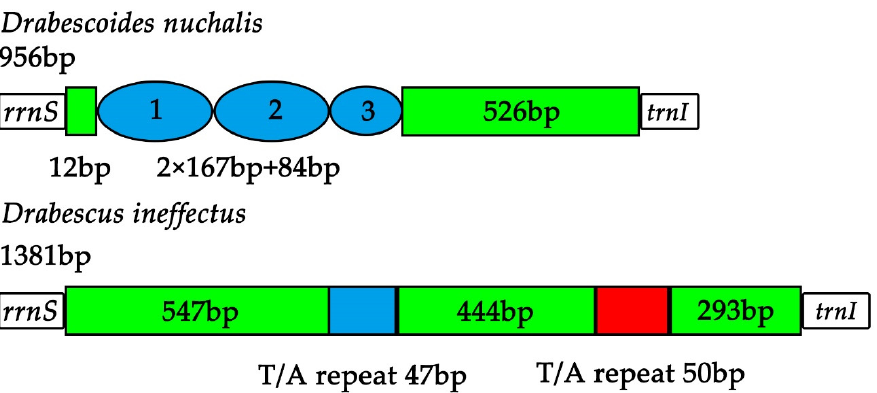
Figure 5. Structures of the A + T ‐ control region in Drabescini mitochondrial genomes. The blue ovals indicate the tandem repeats. The blue and red blocks represent the T/A repeat regions. indicate the tandem repeats. The blue and red blocks represent the T / A repeat